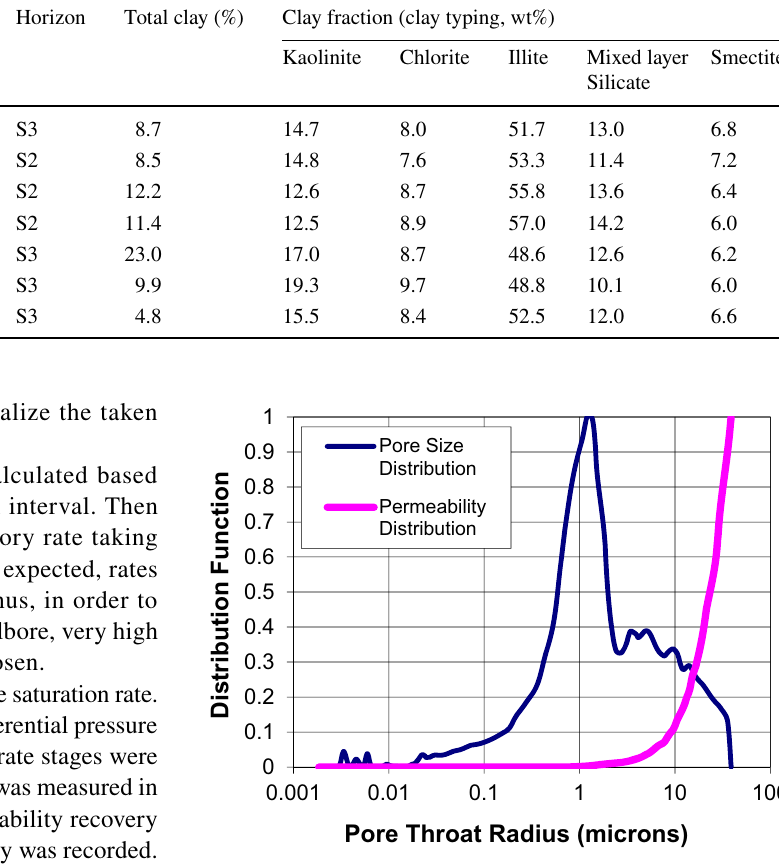
Fig. 3 Pore size and permeability distribution of a bind-stone sample from sample depth 2079.95 m (S3 formation)